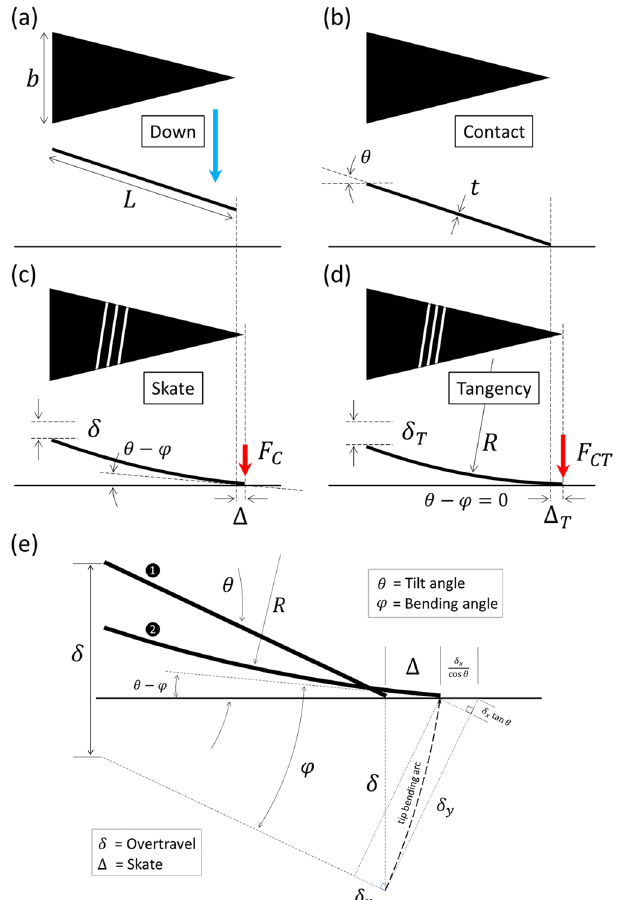
Figure 13. The geometry of the tip of the triangular cantilever skating on a surface due to an imposed overtravel. The model considers a circular bending of the triangular cantilever—this was experimentally verified. The dashed arrow indicates the bending arc of the tip when it skates across the surface due to the imposed overtravel. ( a ) The tilted triangular cantilever descending vertically towards the surface. ( b ) the cantilever tip makes contact with the surface (commonly known as probe touchdown). ( c ) An imposed overtravel causes the cantilever to bend and the tip of the cantilever to skate across the surface—a contact force is generated between the tip and the surface. ( d ) A ‘tangency overtravel’ causes the tip to be tangential to the surface. ( e ) the geometrical situation at the tip during skating due to an imposed overtravel—the bending is circular for a triangular cantilever.